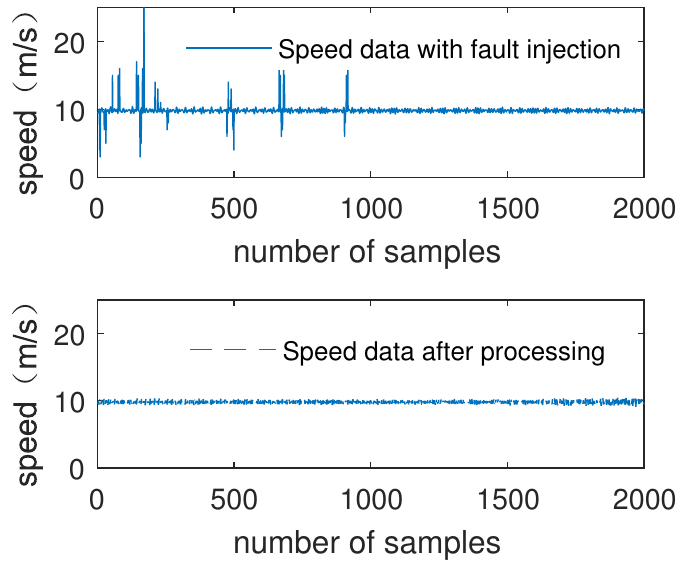
Figure 9. Single input of speed data with fault injection and processed data.